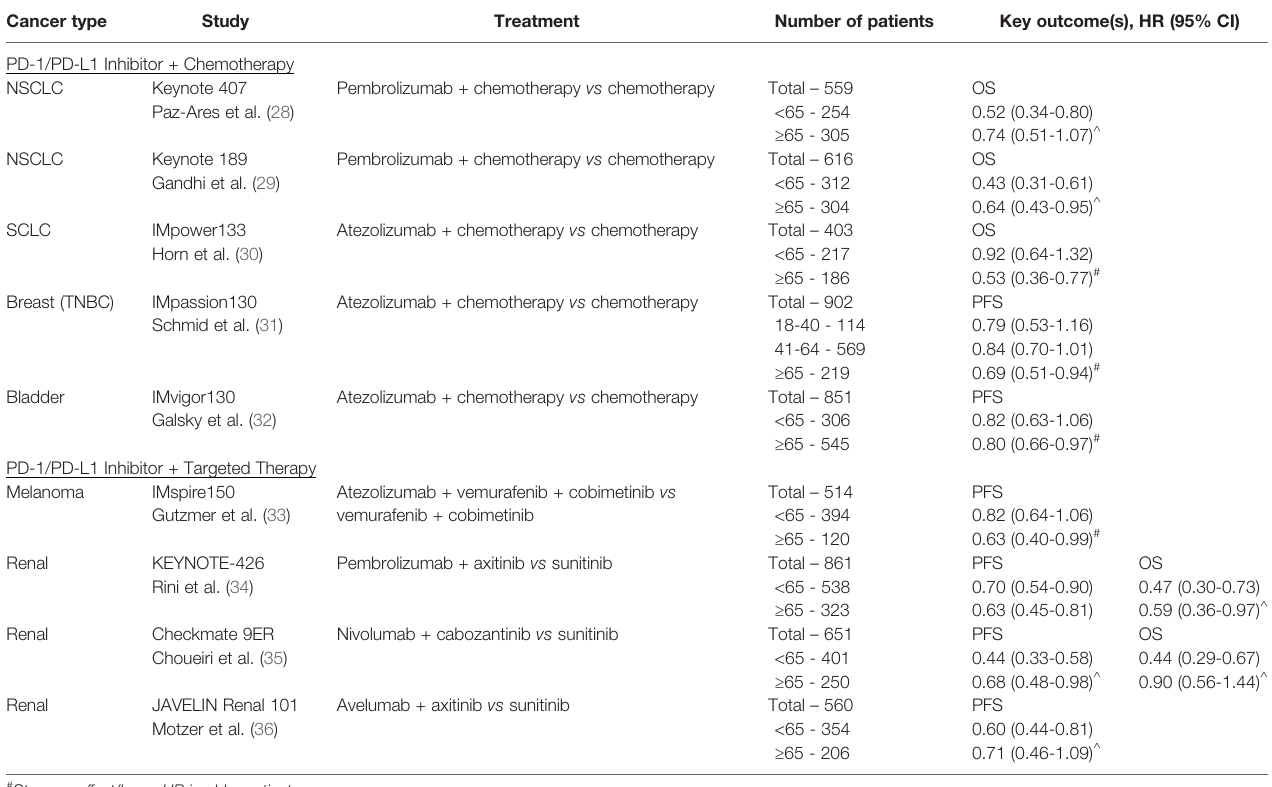
TABLE 2 | Select phase III trials of chemoimmunotherapy and ICI-targeted therapy in advanced disease. Cancer type Study Treatment Number of patients Key outcome(s), HR (95%